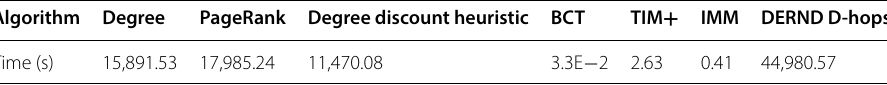
50 under the IC model =